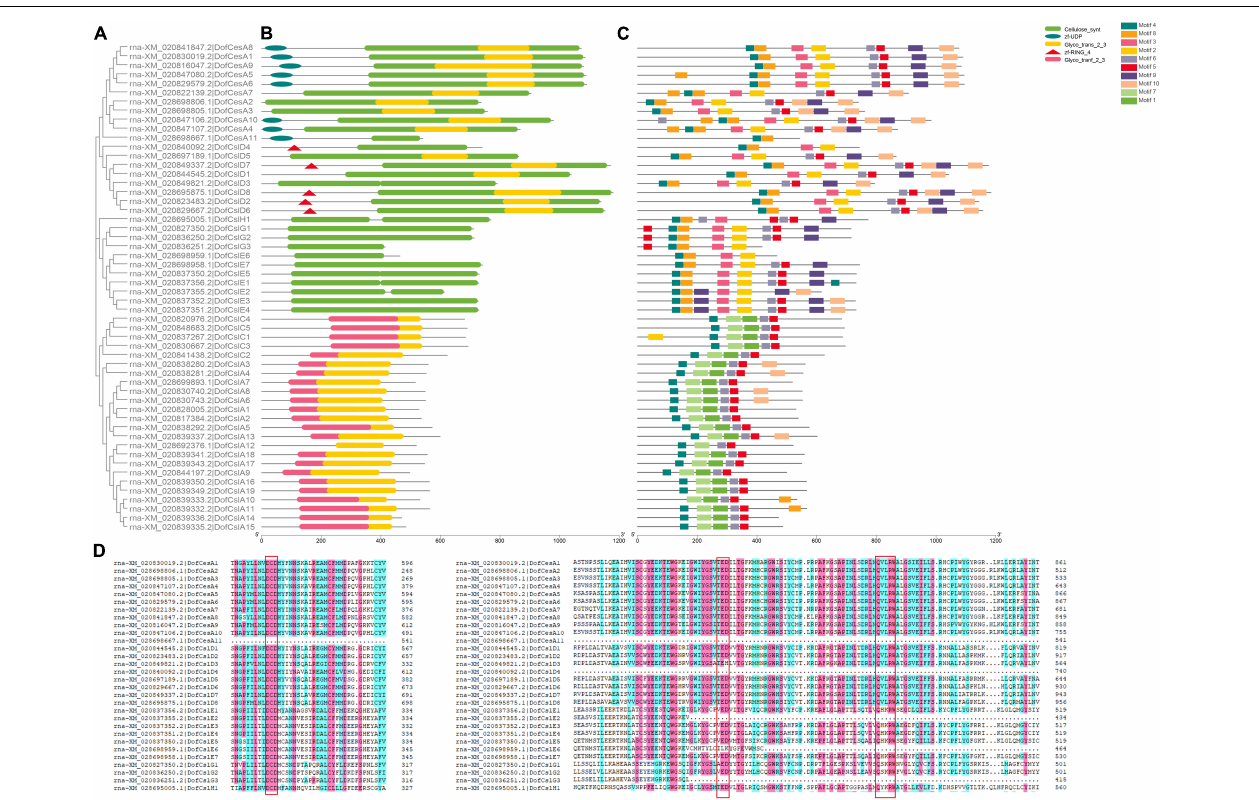
FIGURE 3 | Phylogenetic, conserved domain and motif analyses of Cellulose synthase proteins in D. officinale (Dof). (A) Phylogenetic tree of the DofCesA/DofCsl proteins; (B) Schematic presentation of the domains of the DofCesA/DofCsl proteins; (C) Schematic presentation of the conserved motifs in the DofCesA/DofCsl proteins; (D) Comparison of the deduced amino acid sequences of Cellulose synthase in D. officinale . The conserved cysteine residues are marked by red frames. The full versions of multiple alignments of the DofCesA/DofCsl protein sequences are shown in Supplementary Figure S5 . The scale bar (aa) indicates the amino acid position within the corresponding conserved